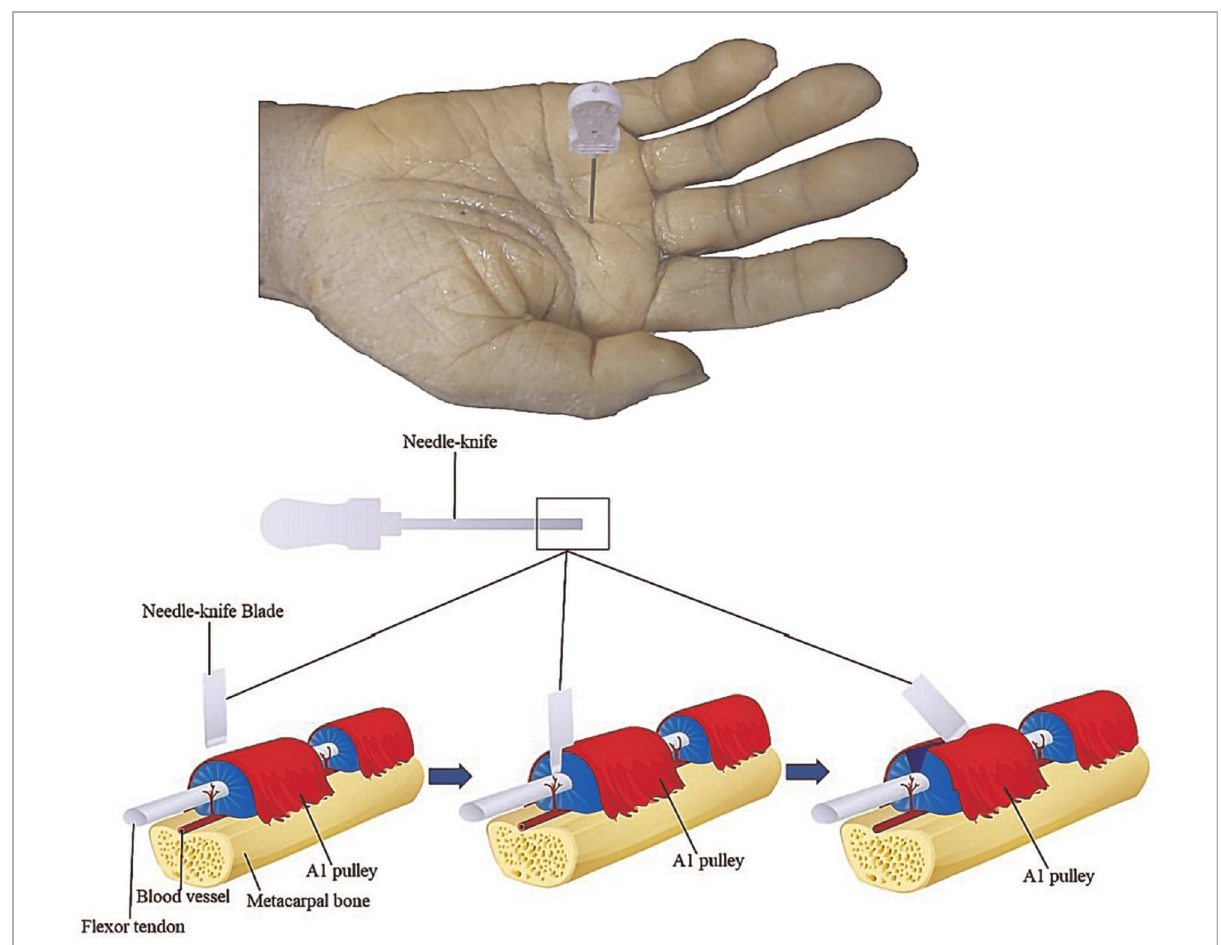
FIGURE 3 Schematic diagram of classical needle knife